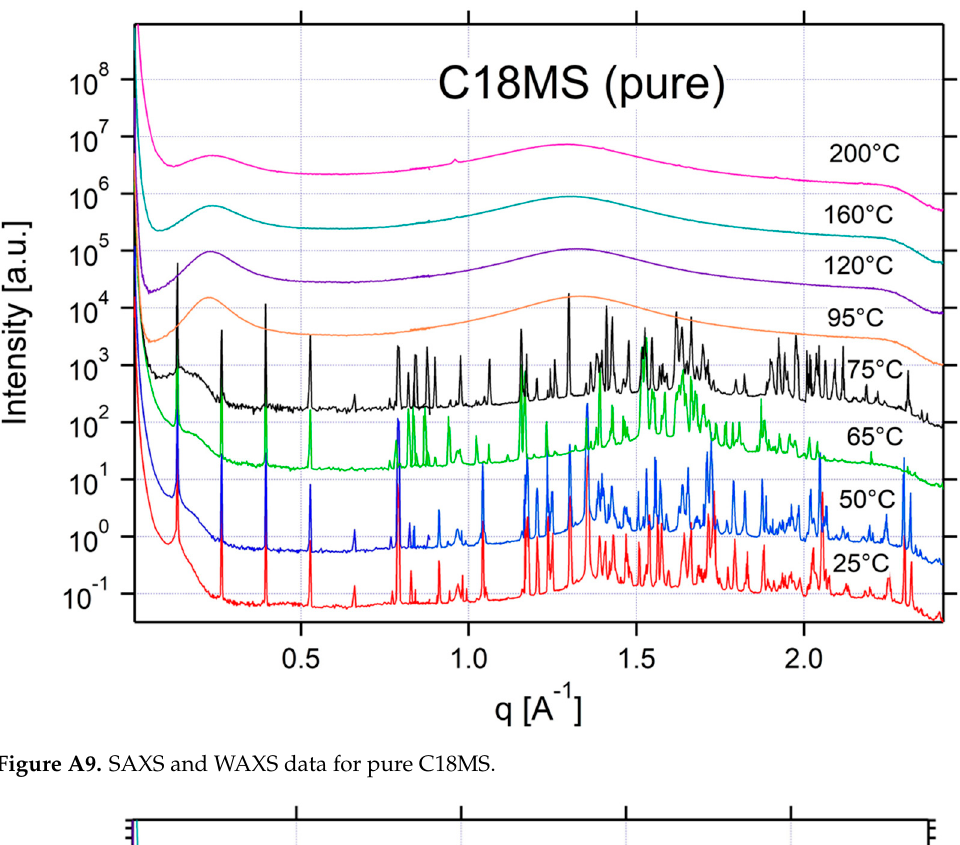
Figure A9. SAXS and WAXS data for pure C18MS.